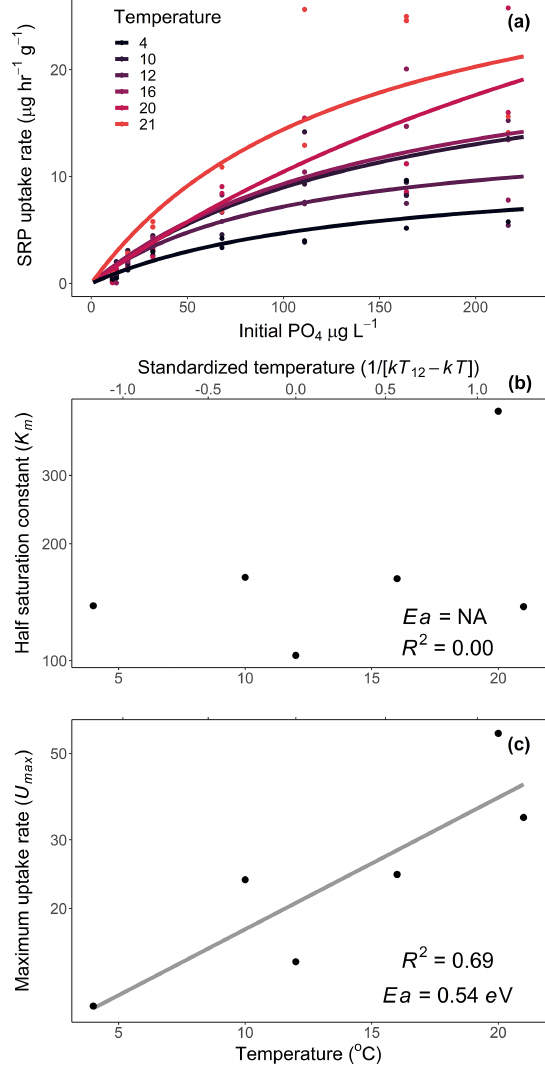
different initial concentrations of SRP grouped by temperature (a) . The lines represent the best-fit Michaelis–Menten kinetics, and the effect of temperature on the Michaelis–Menten parameters, the half- saturation constant ( k m , b ), and the maximum uptake rate ( U max , c ) are represented in centered Boltzmann–Arrhenius plots. In (c) the gray line indicates the best fit, which represents the activation en- ergy in units of electron volt. Equations and model fits for lines in (a) are given in Table A2. See Table 2 (experiment 2) for informa- tion on model fit and significance associated with (b) and (c)